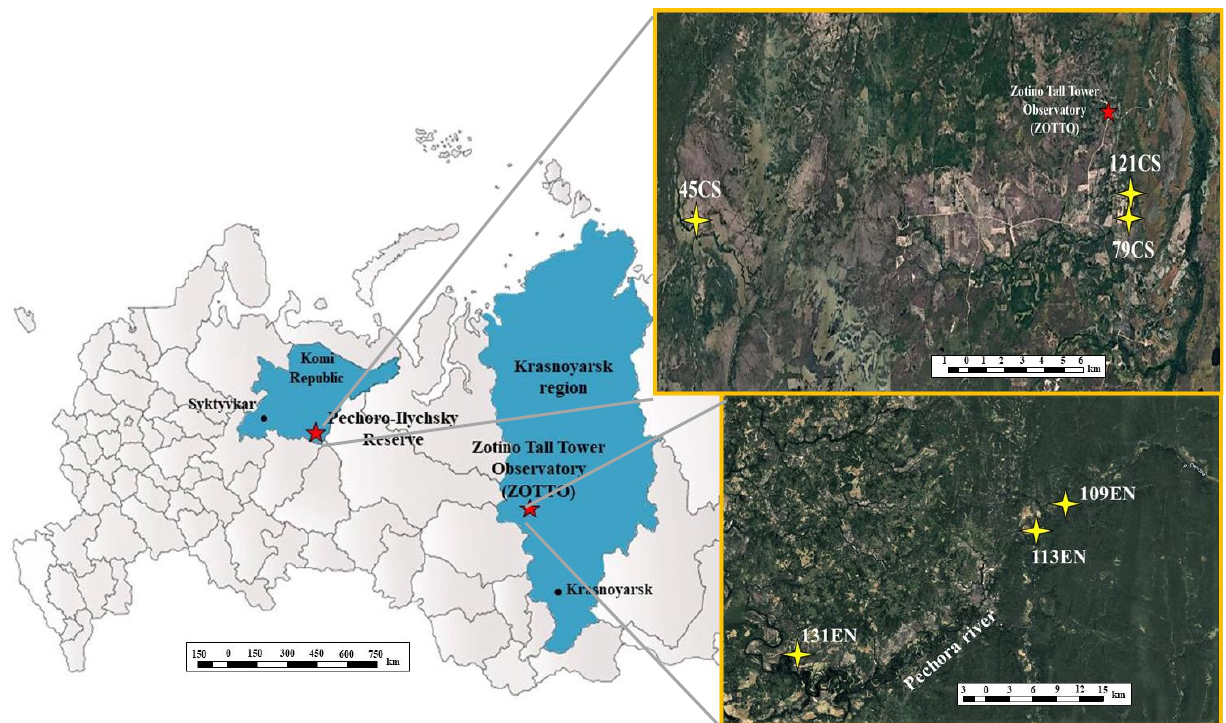
Figure 1. Location of study sites (the scheme is based on https://glovis.usgs.gov/, accessed on 25 May 2022).